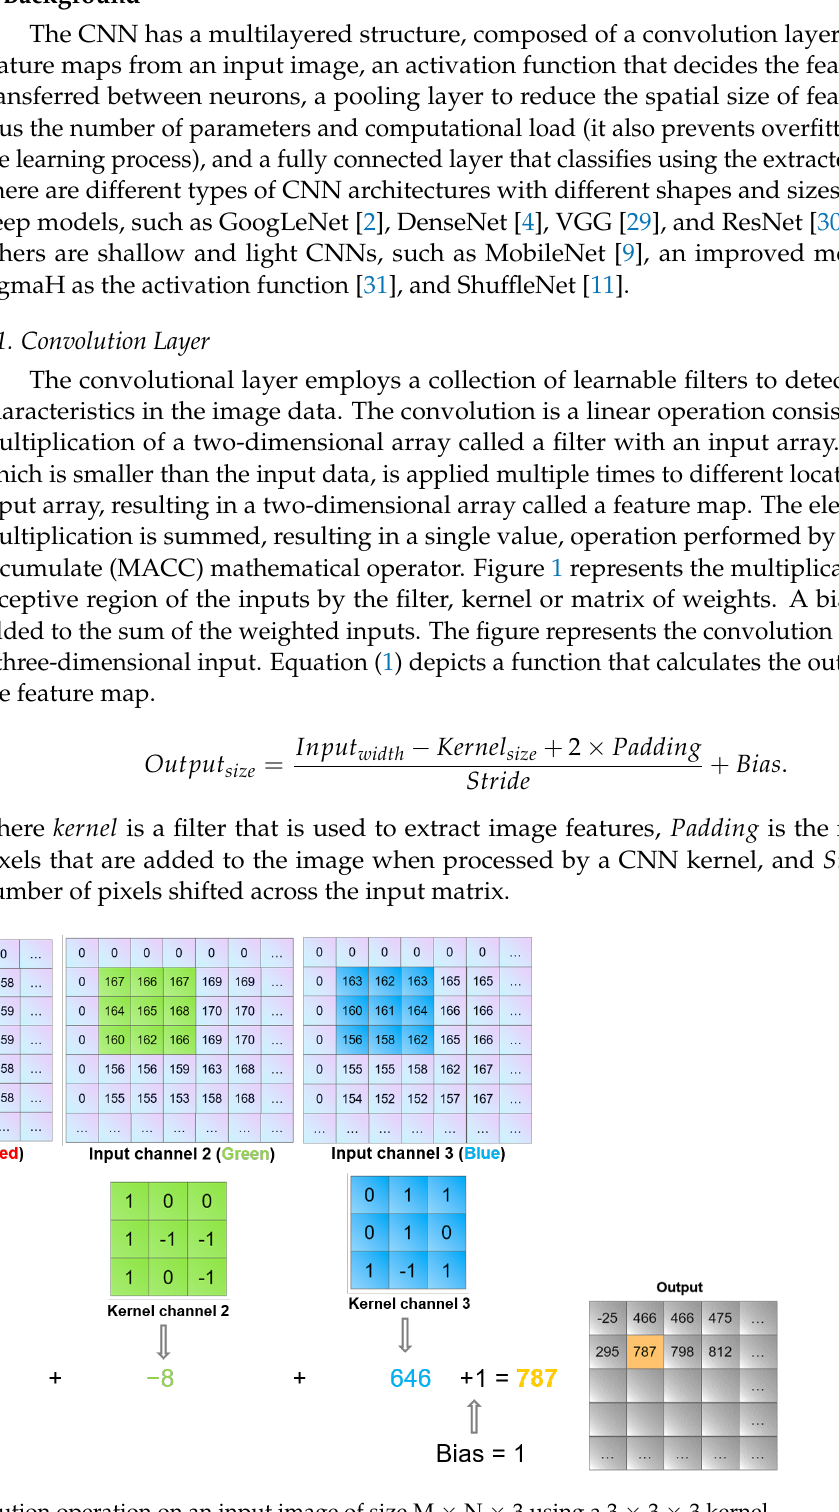
Figure 1. Convolution operation on an input image of size M × N × 3 using a 3 × 3 × 3